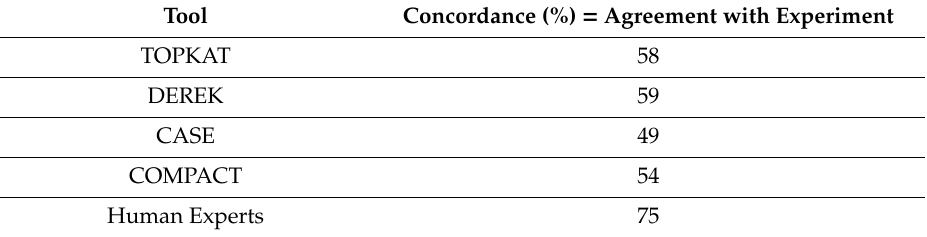
Table 3. The performance of some well-known in silico tools for the prediction. Table taken from Reference